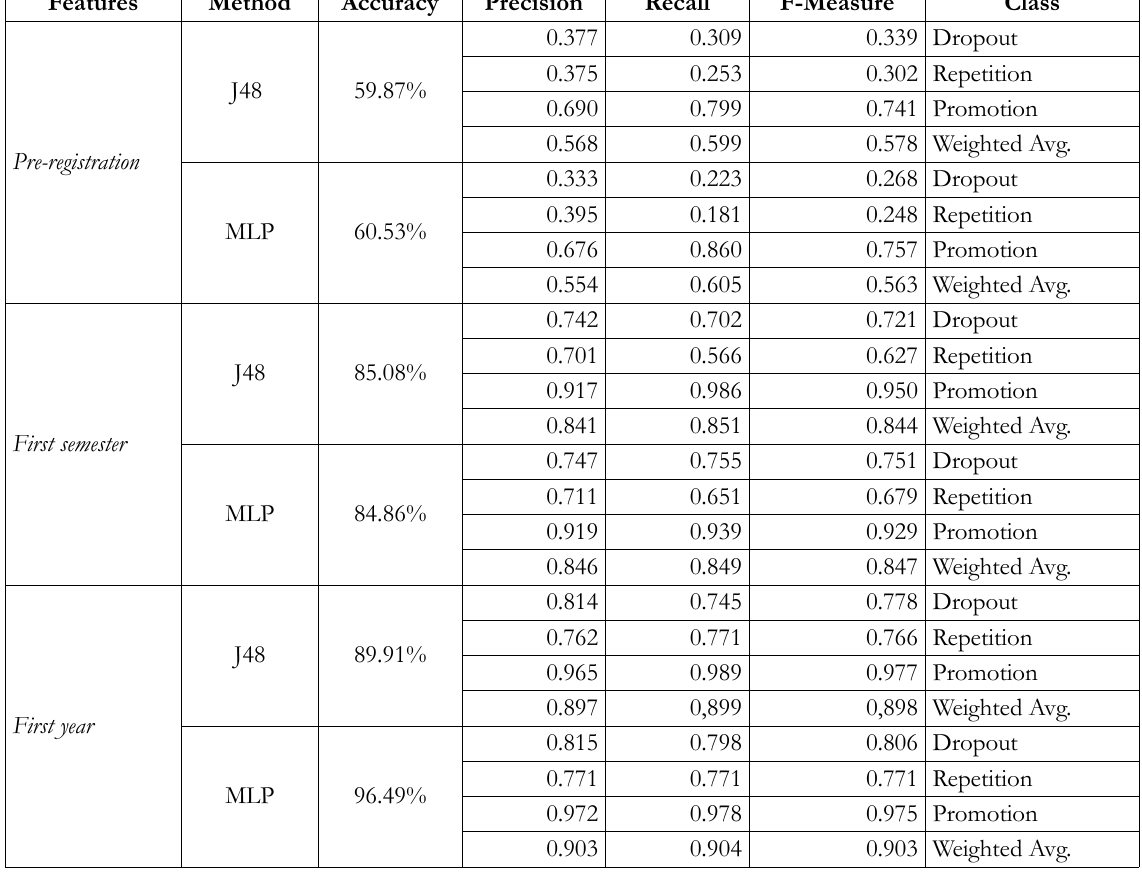
Table 2. Results considering three